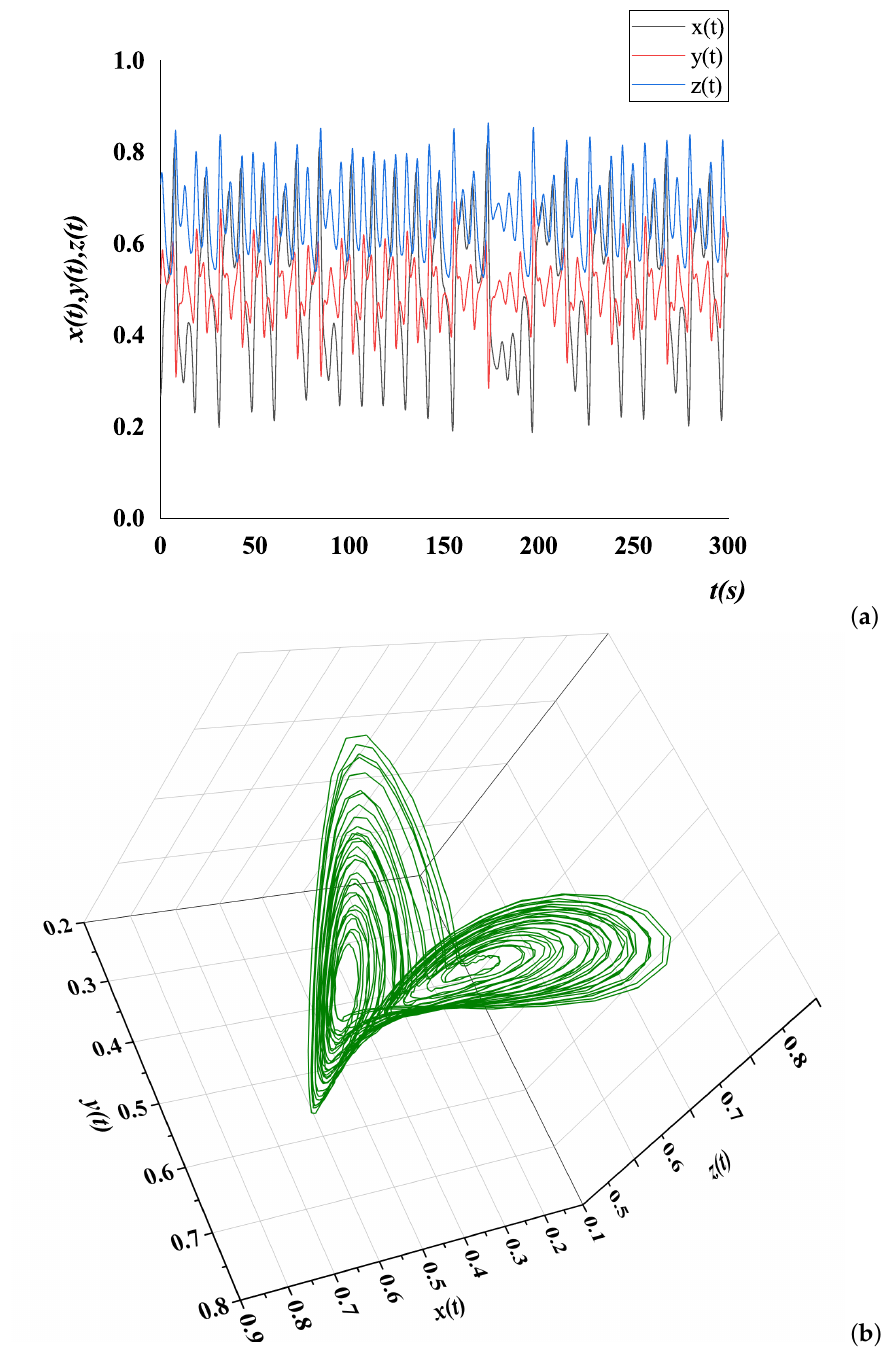
Figure 10. ( a ) The nonlinear time series of the Shimizu-Morioka system, as this was calculated using SC, beginning from initial conditions ( X , Y , Z ) = (0.51,0.51,0.51) and N = 22 bits, N acc = 2 12 iterations. ( b ) The corresponding